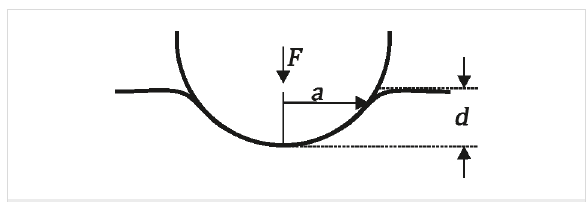
Figure 4: Contact area between sphere and flat elastic surface. F : Normal force. a : indentation radius. d : Indentation depth. Image modified after Popov [37].